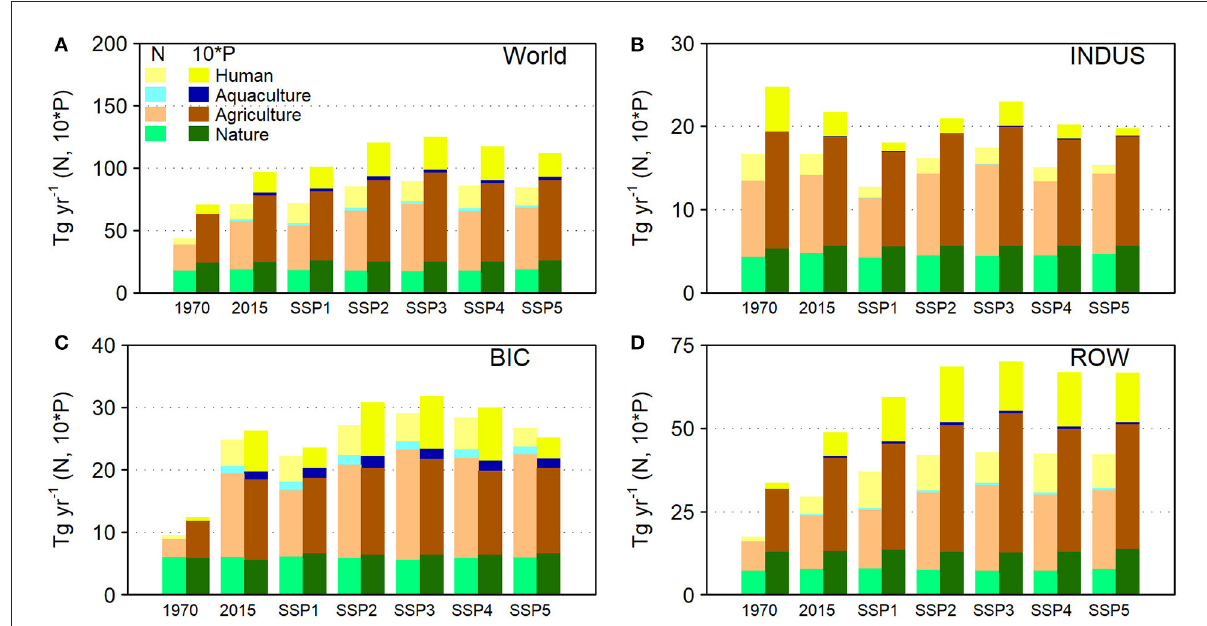
FIGURE2 Annual total N and total P delivery for (A) the world; (B) industrialized countries in North America, Europe including the Russian Federation, Japan and Oceania (INDUS); (C) Brazil, India and China (BIC) and (D) the rest of the world (ROW) for 1970, 2015, and 2050 for the five